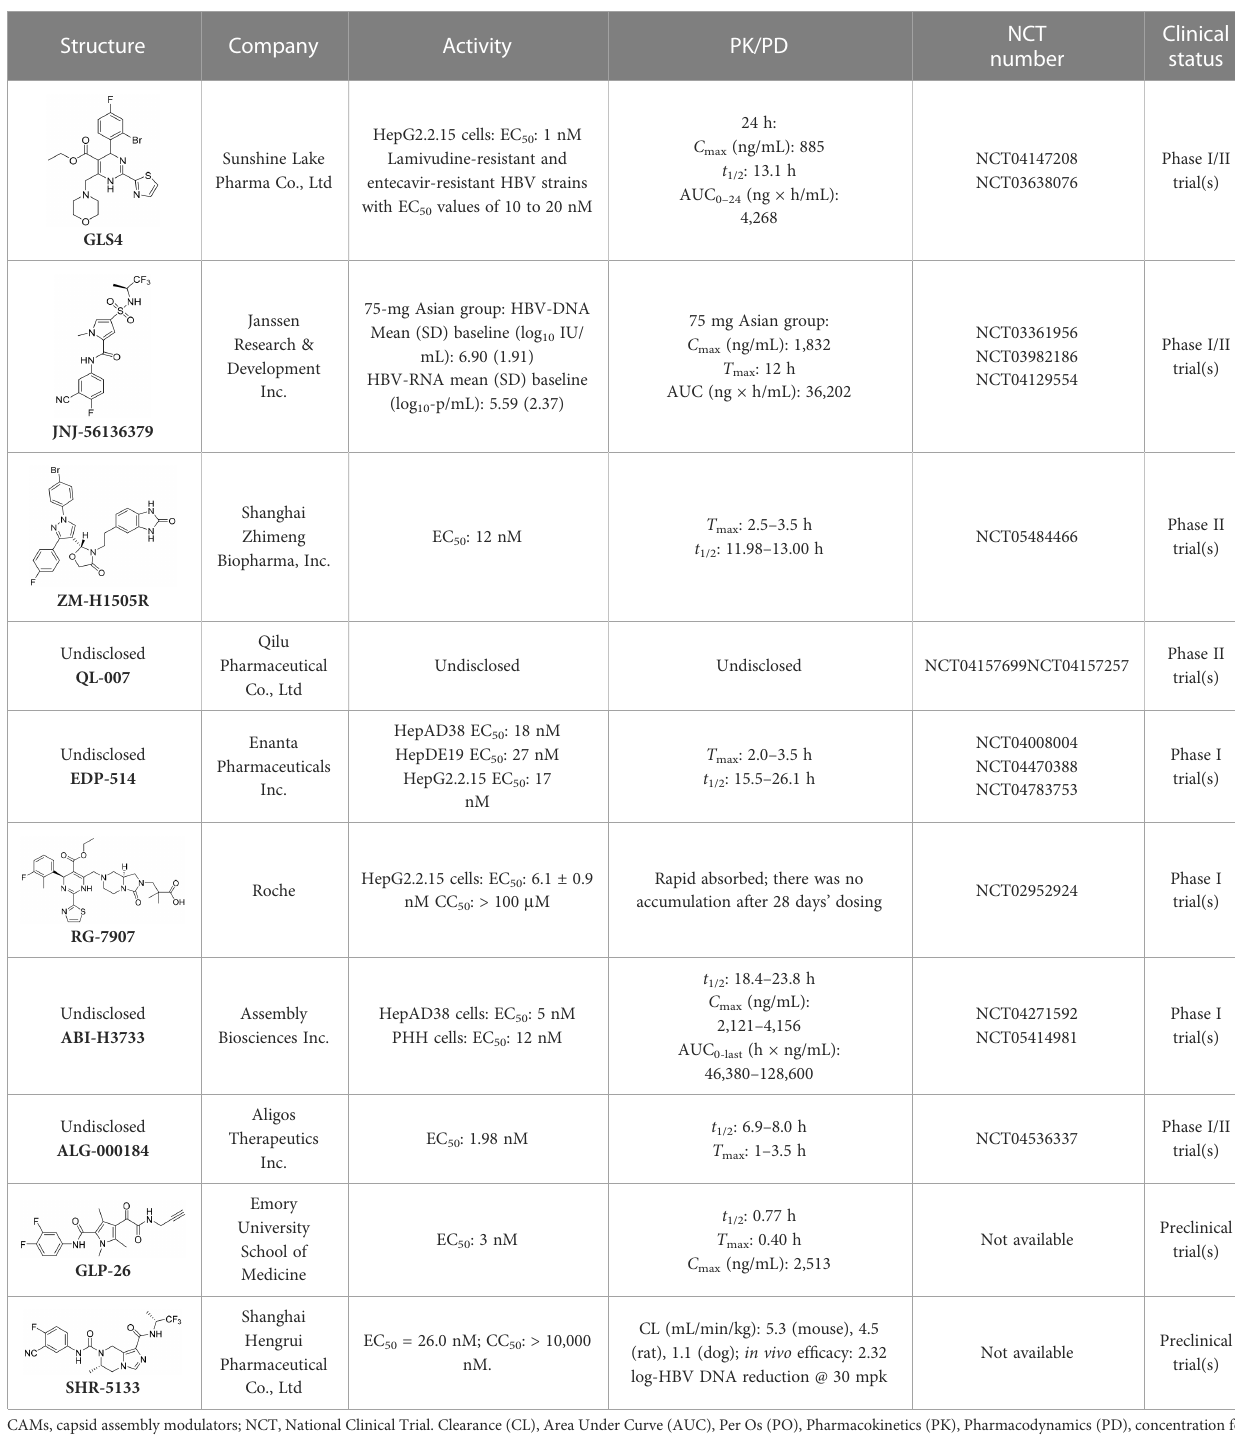
TABLE 4 Summary of